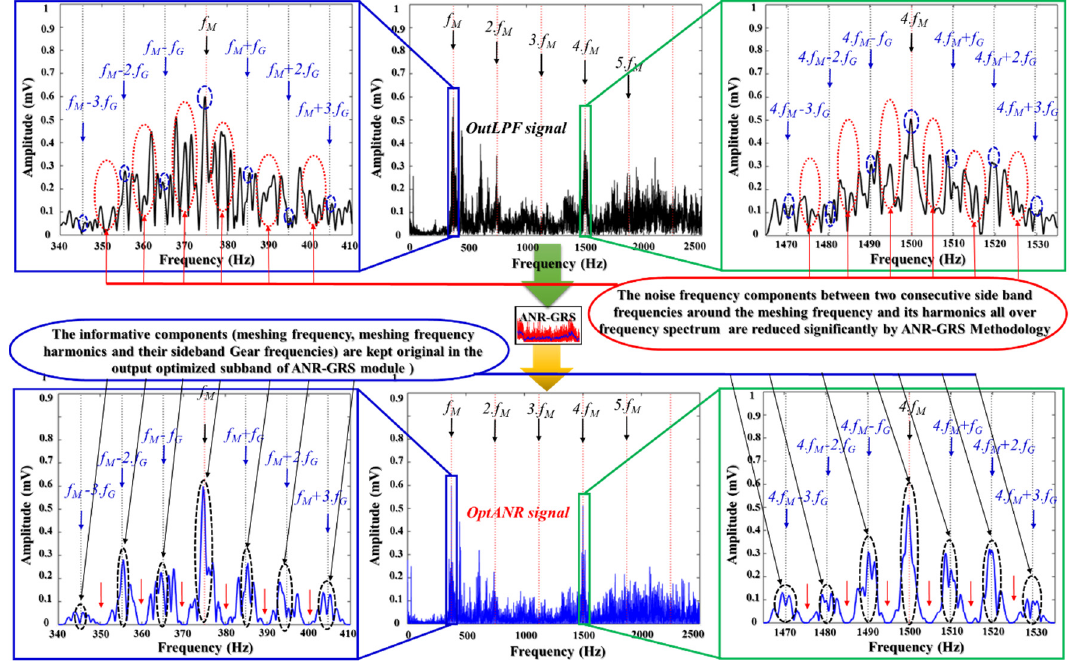
Figure 13. Frequency spectrum analysis of the input and output signal of the ANR-GRS module.